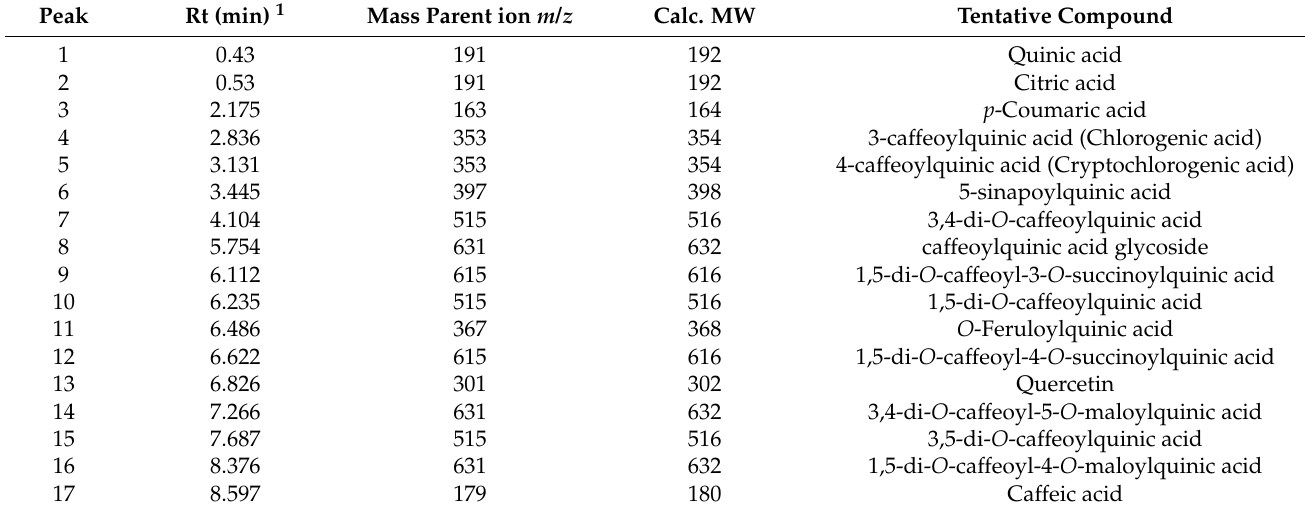
Table 3. UPLC-MS identification of main phenolic compounds in Burdock root